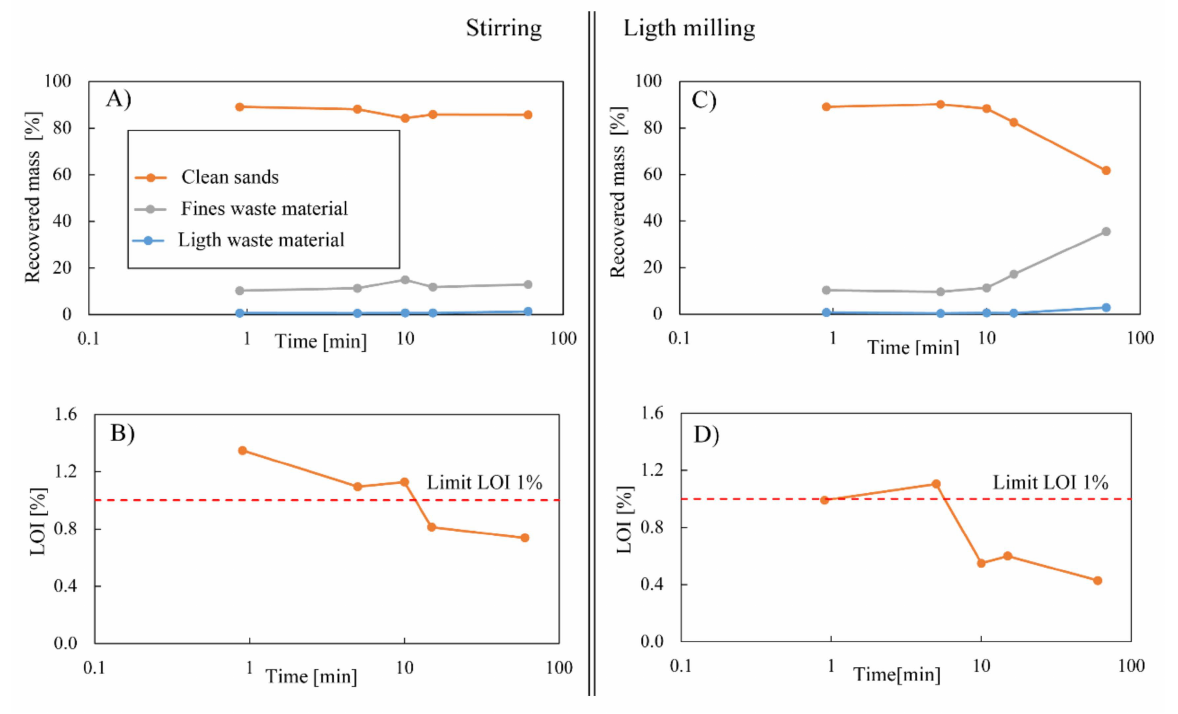
Figure 8. Comparative results of the liberation test. ( A ) Recovered mass using stirring, ( B ) LOI